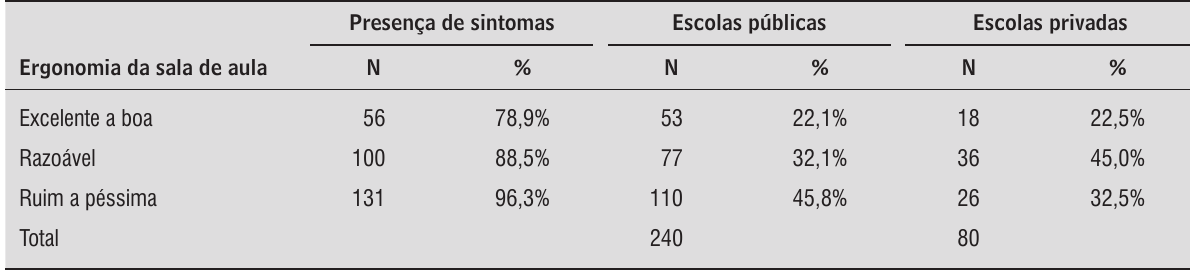
Ergonomia da sala de aula